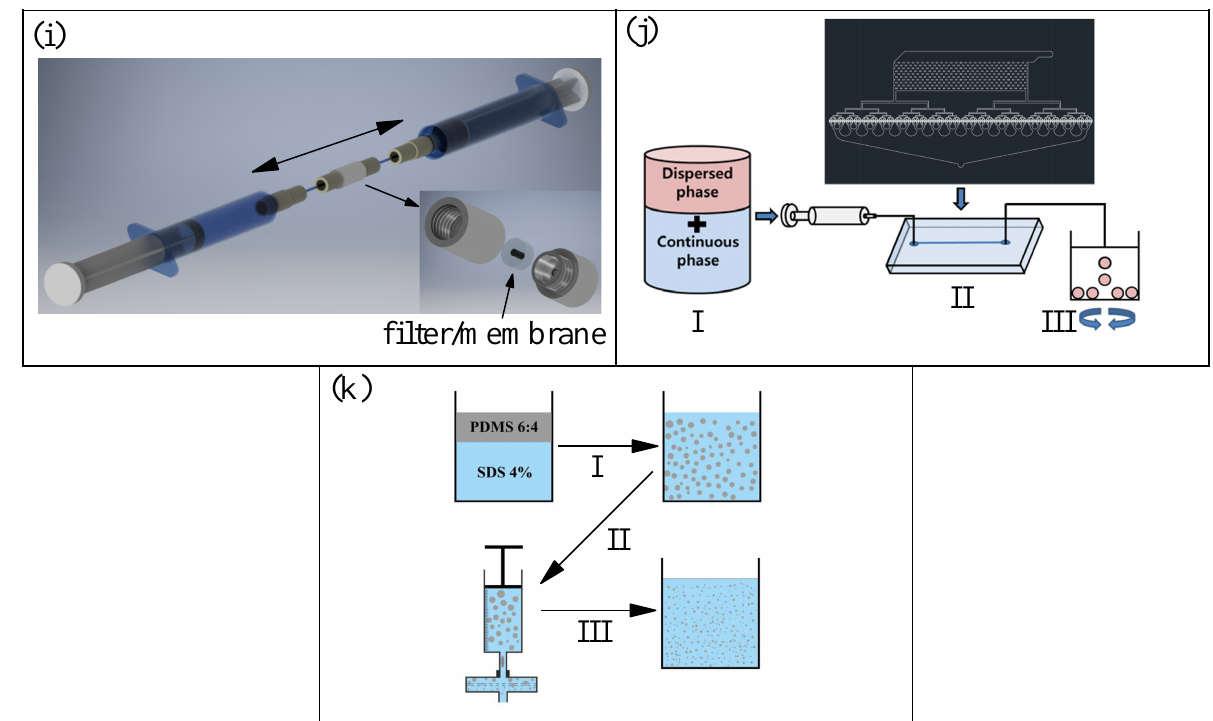
Figure 1. Production methods of RBC templates: ( a ) electrohydrodynamic jetting [33,34], ( b ) stop flow lithography (SFL) [35,36], ( c ) PRINT ® [37,38], ( d ) Layer-by-Layer [40–42], ( e ) CAP ATRP [43], ( f ) liquid–liquid flow-focusing with a hypodermic needle [44–46], ( g ) electrospray with solvent diffusion [47], ( h ) lipid film hydration [48,49], ( i ) two-syringe membrane emulsification [50], ( j ) 512-channel geometric droplet-splitting microfluidic device combined with a post array part [51], and ( k ) premix membrane emulsification [52]. Roman numerals are used to explain, in the text, the main steps for each production method. Reproduced from Refs. [34,35,37,40,43,44,47,48,50–52] with permission from National Academy of Sciences, WILEY-VCH Verlag GmbH, American Chemical Society, AIP Publishing, Elsevier Science INC, MDPI, and The Royal Society of Chemistry. Figure 1d Layer-by-Layer [40–42,53]: (I) adsorption of negatively charged first